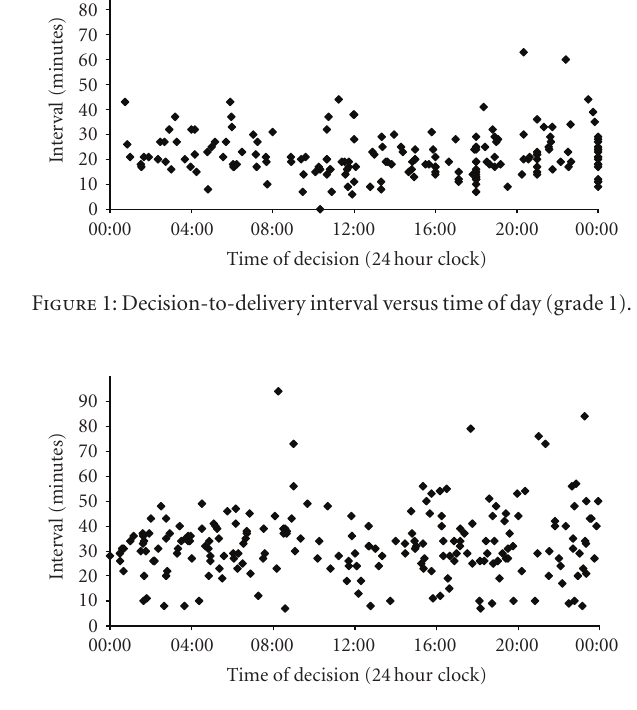
Figure 2: Decision-to-delivery interval versus time of day (grade